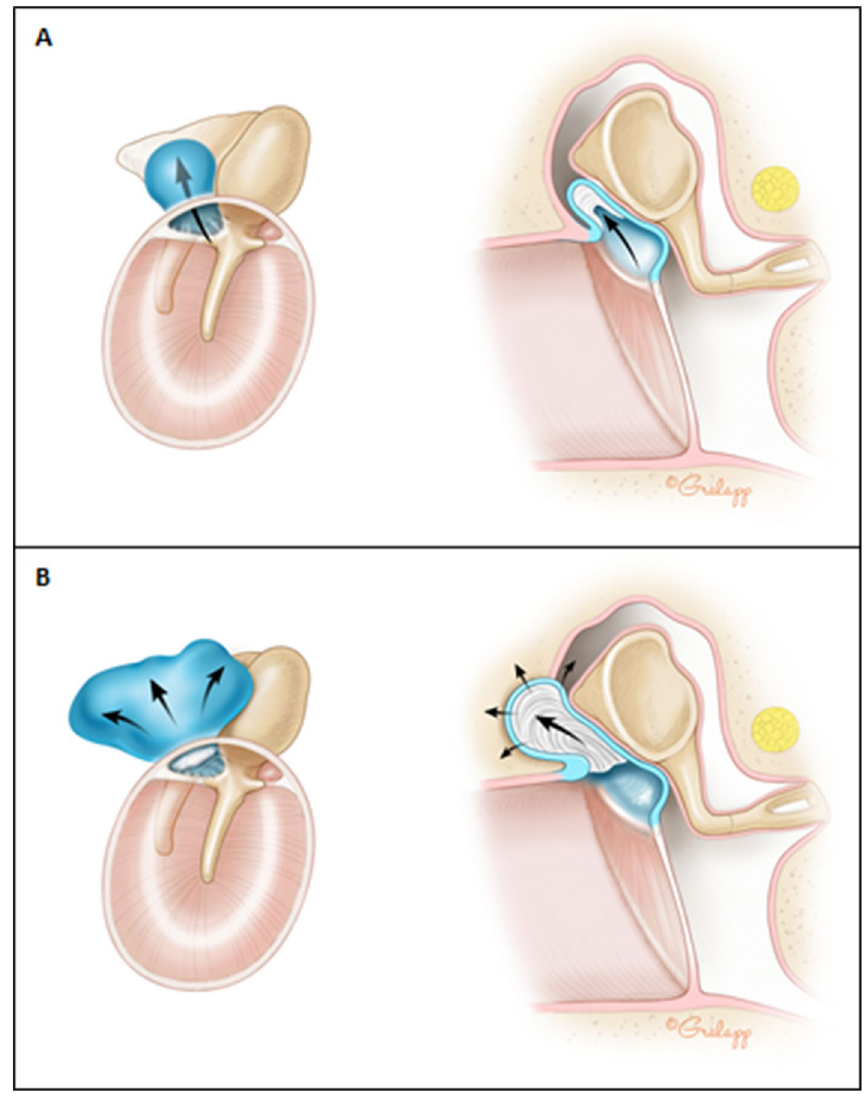
progression into the middle ear and mastoid space with erosion of ossicles and potentially other bony structures as well. Of note, cholesteatoma can also commonly be acquired from a tympanic membrane perforation, or may also be congenital in origin. Illustration Chris Gralapp 3